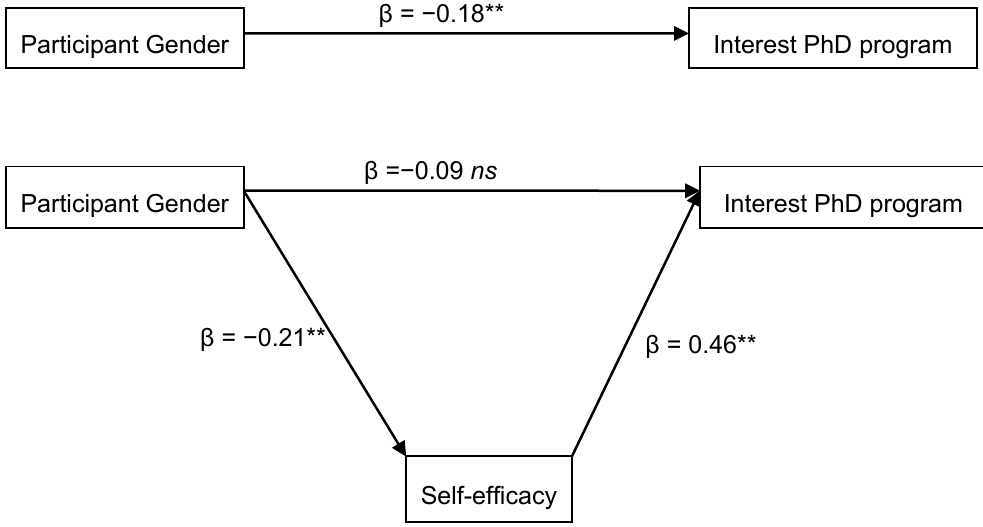
Figure 1. Self-efficacy significantly mediated the overall gender difference in interest in the PhD program, * p < 0.05, ** p < 0.01.